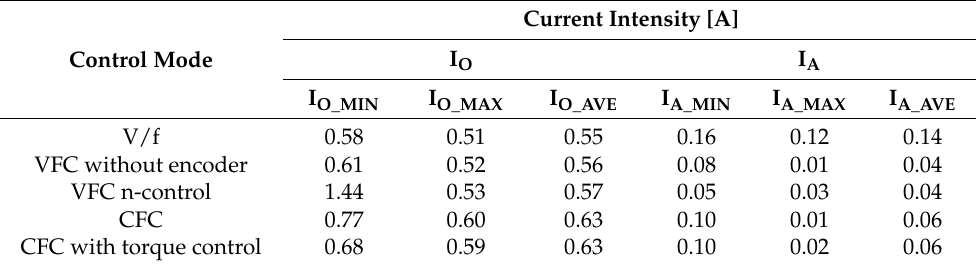
Table 5. Characteristics of the output current (I O ) and the active current (I A ) in a steady state (without an external load).